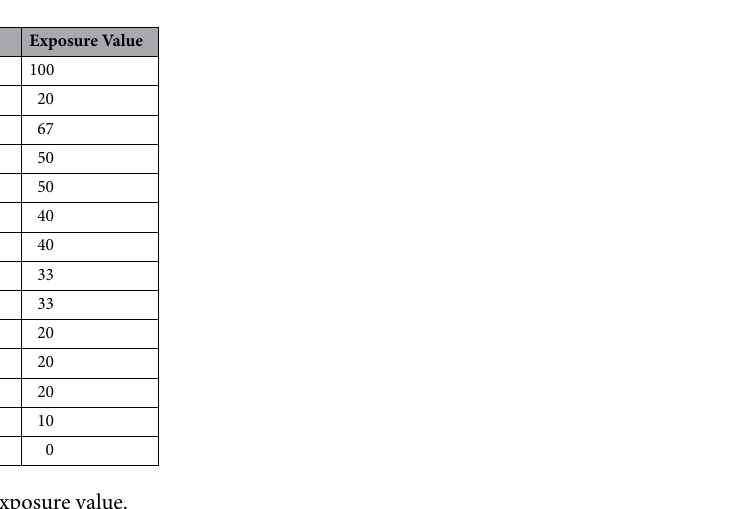
Table 4. Occupation and exposure